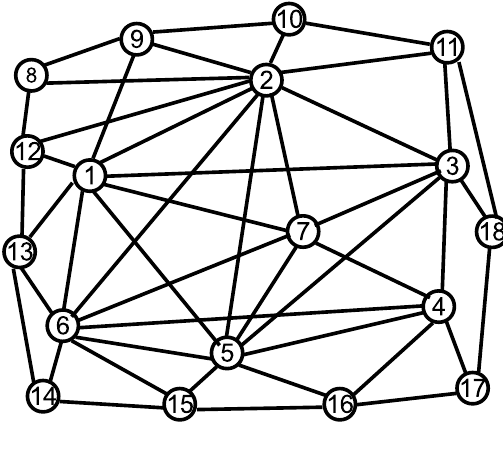
Figure 2. Illustration of global location